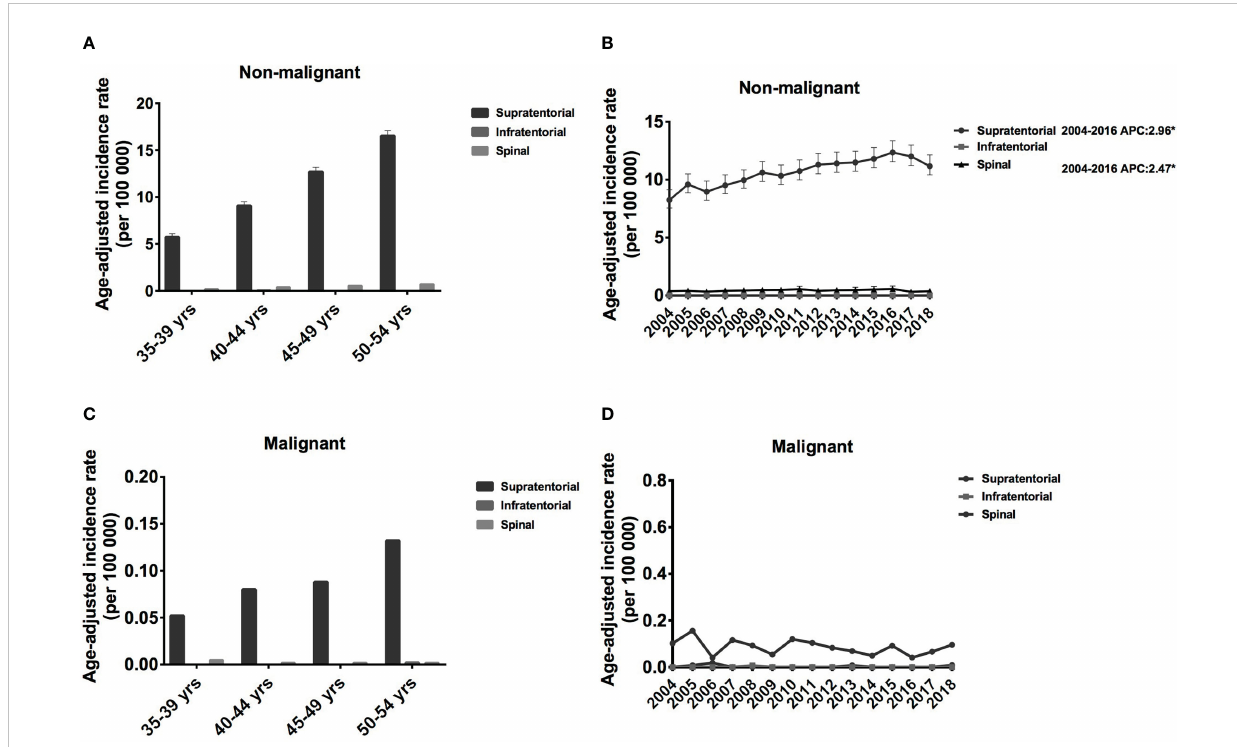
FIGURE 4 Age-adjusted incidence rates (IRs) and annual percent changes (APCs) by age and tumor location. IRs by tumor location and by 5-year age intervals (A, C) , APCs by tumor location over time from 2004 – 2018 (B, D) . (A, B) , non-malignant meningioma; (C, D) , malignant meningioma. *Only show APCs that are signi fi cantly different at the P < 0.05